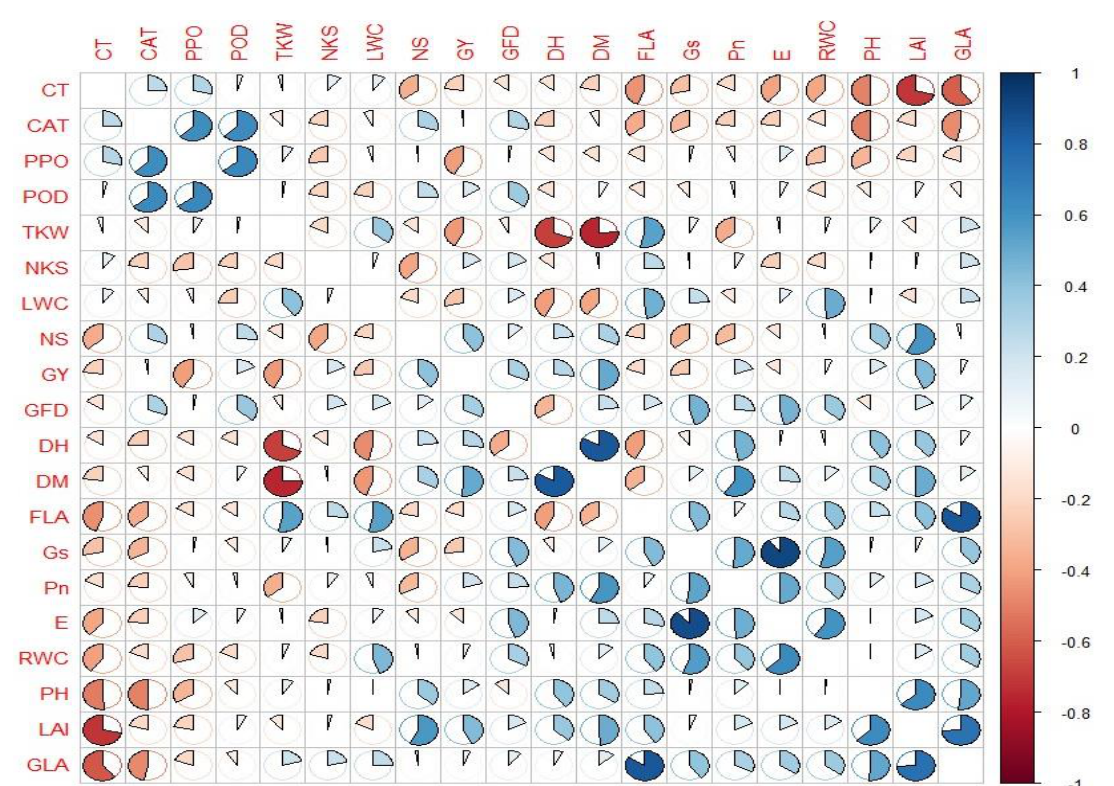
Figure 2. Phenotypic (upper diagonal) and genotypic (below diagonal) correlations among the 20 studied traits obtained from nine environments (n =180). Abbreviations as described in materials and methods . Table 3. Principal component analysis and factor analysis (factorial loadings obtained using the varimax rotation and resulting communalities).